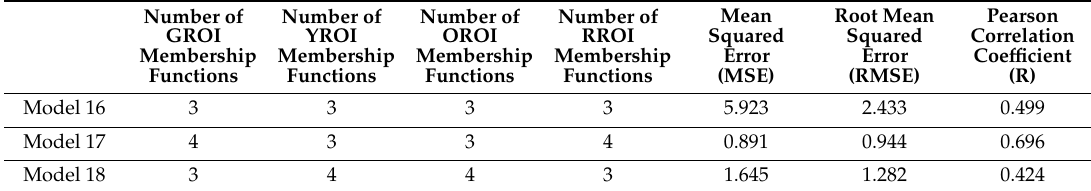
Table 5. Models using FL prediction of ◦ Brix.